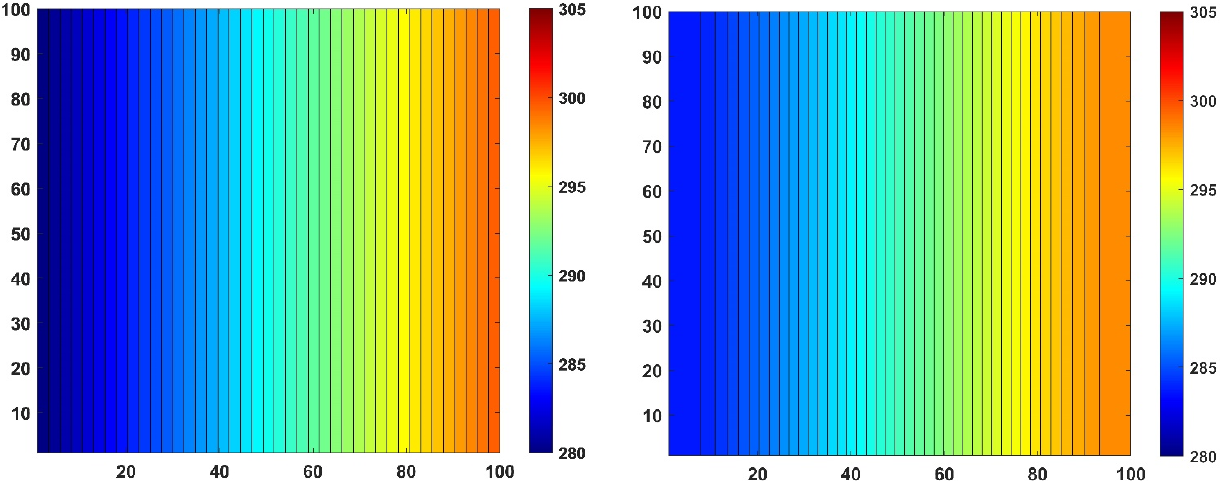
Figure 12. The temperature distribution contour in Kelvin units for the equidistant mesh at initial (left) and final time (right), in the case of a surface area (Experiment 5). The coordinates in cm units are represented by the numbers on the vertical and horizontal axes, which are the cell indices as well.